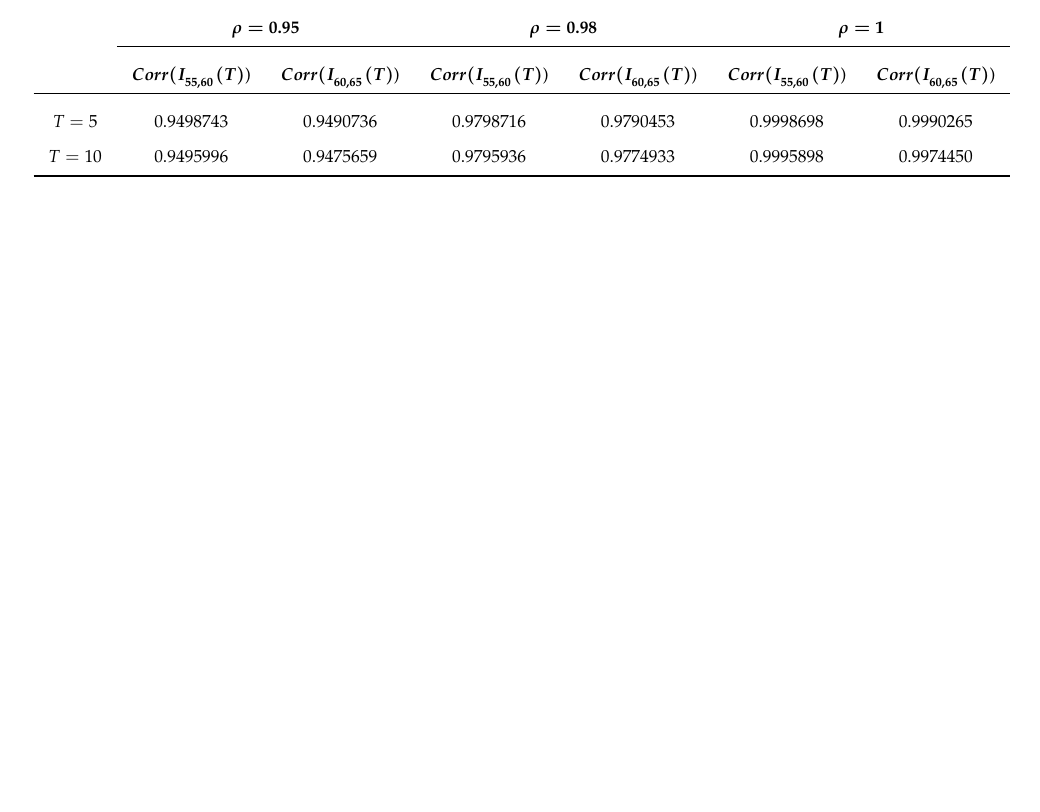
Table 5. Values of Corr ( I y , z ( T ))